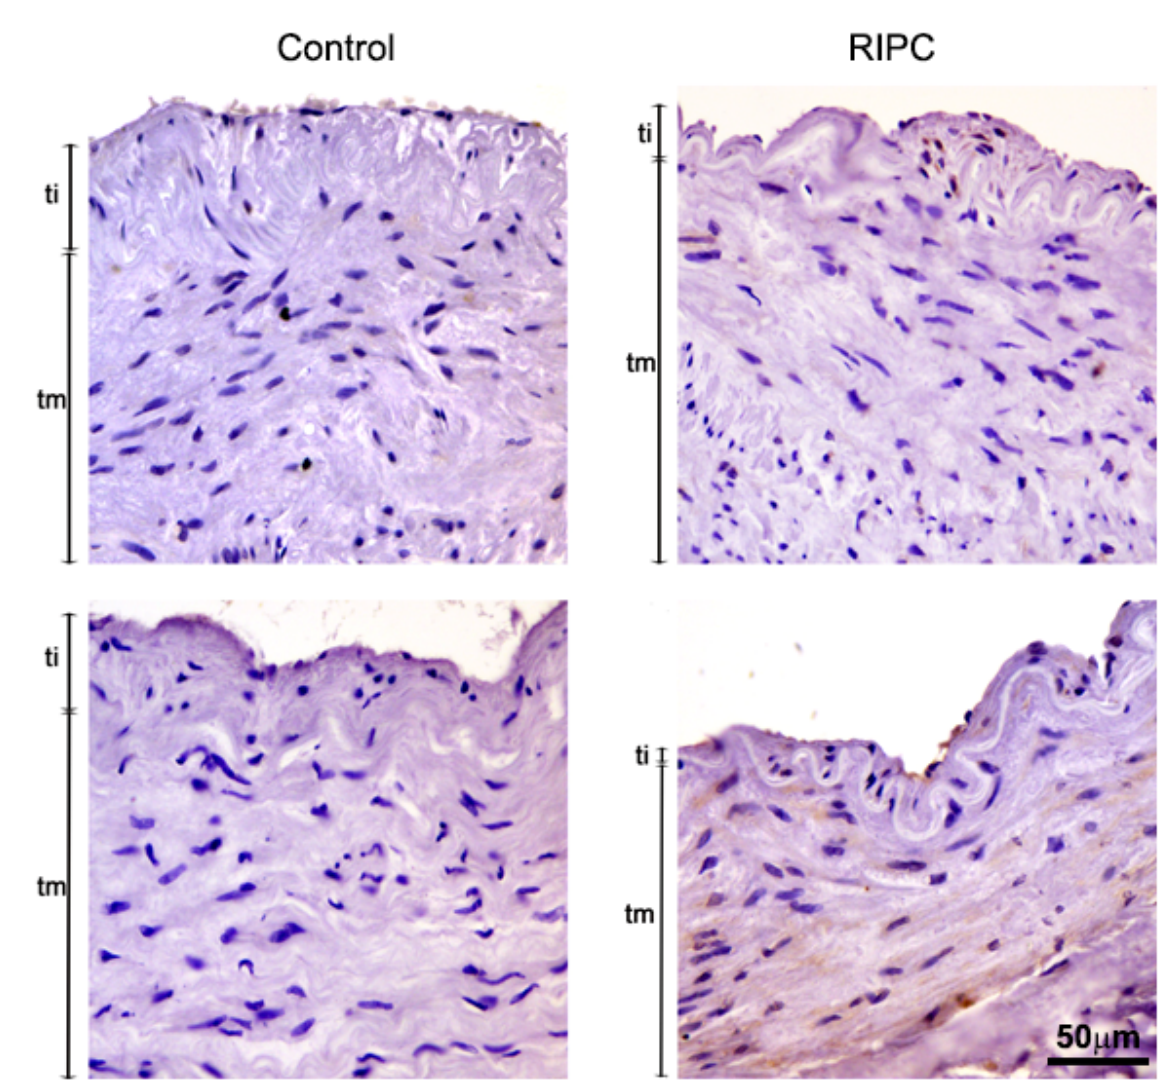
Figure 3. Immunohistochemical analysis of iNOS in tunica interna (ti) and tunica media (tm) of ITA from non-RIPC (control) patients ( left ) and patients with applied RIPC protocol ( right ) during urgent CABG. Immunopositivity for iNOS in non-RIPC patients is weak, mostly detected in the endothelium, while RIPC patients show slightly higher iNOS immunopositivity in tunica interna and tunica media in smooth muscle cells. Scale bar: 50 μ m.